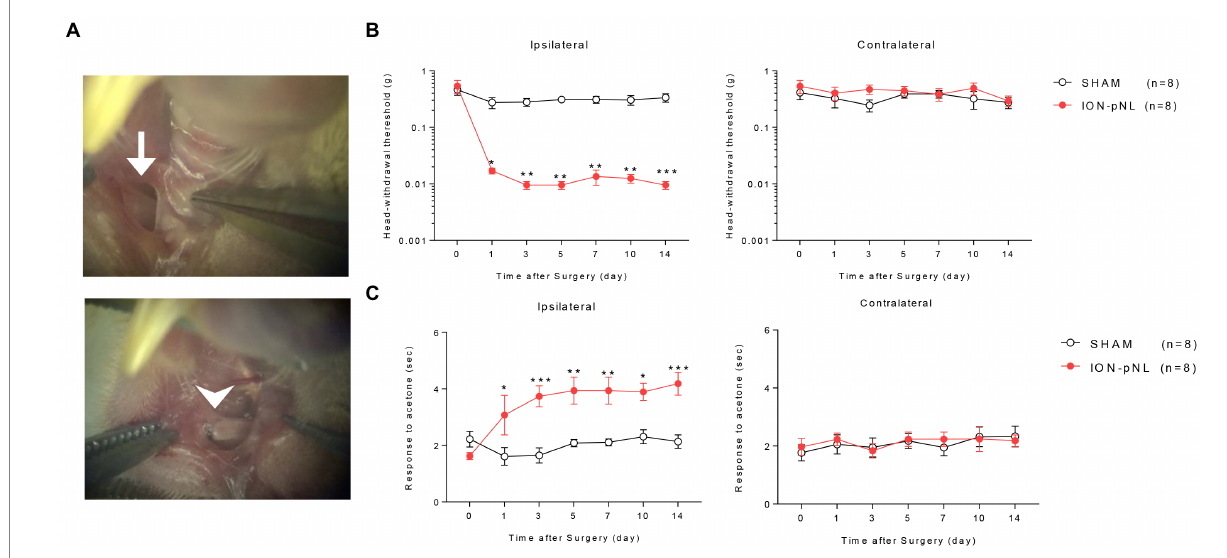
FIGURE 1 Development of a mouse model for chronic mechanical and cold allodynia after infraorbital nerve injury. Images in the left panel show the infraorbital nerve and partial ligation (ION-pNL) surgical approach (A) . The left ION was exposed (arrow) and tightly ligated with 8–0 silk at approximately 2/3 the nerve diameter (arrowhead). Infraorbital nerve injury group (ION-pNL) showing a significant decrease in 50% head withdrawal threshold from day 1 to 14 only on the ipsilateral side following infraorbital nerve injury (B) . * p < 0.05, ** p < 0.01, *** p < 0.001 compared with the sham surgery group (SHAM). In addition, the rubbing response time to acetone application was significantly increased in ION-pNL mice from day 1 to 14 following infraorbital nerve injury (C) . * p < 0.05, ** p < 0.01, *** p < 0.001 as compared with SHAM, n = 8 per